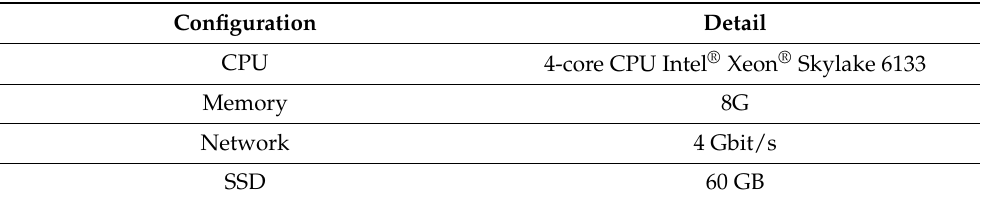
Table 4. Experimental environment configuration.